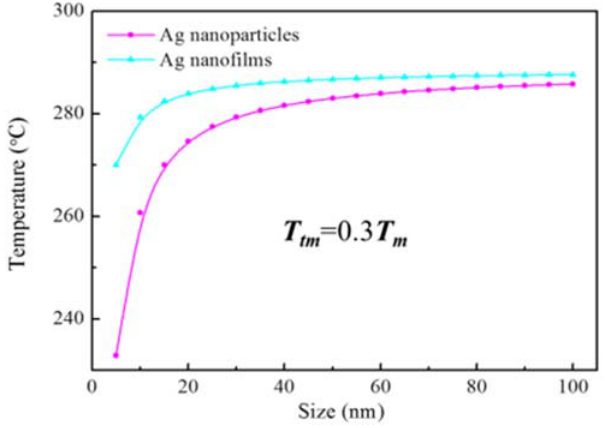
Figure 3. Tamman temperature of Ag nanoparticles and Ag nanofilms.